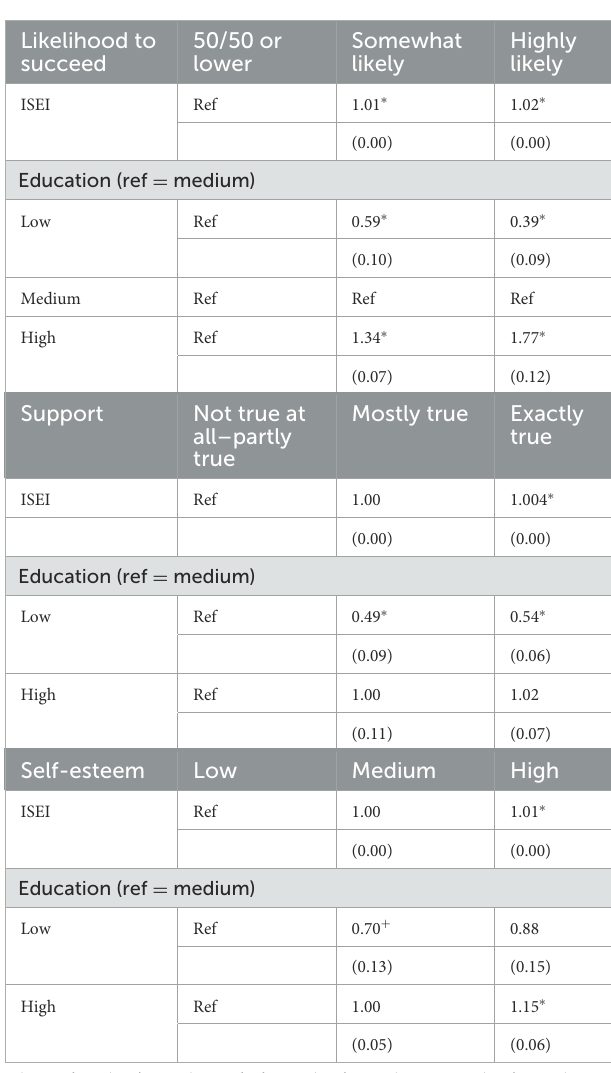
TABLE 5 Multinomial logistic regression analyses between psychosocial resources and socio-economic background of parents. Likelihood to succeed